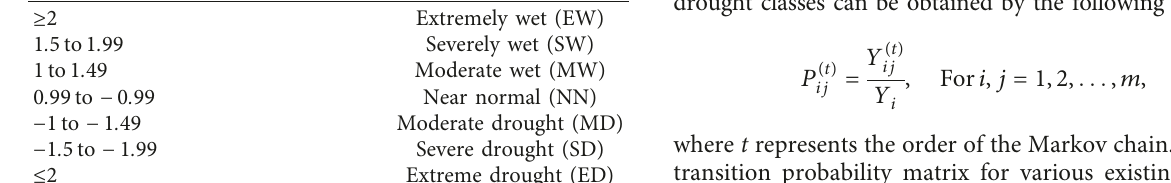
Table 1: Drought classification criteria of SPTI [27]. SPTI values Drought